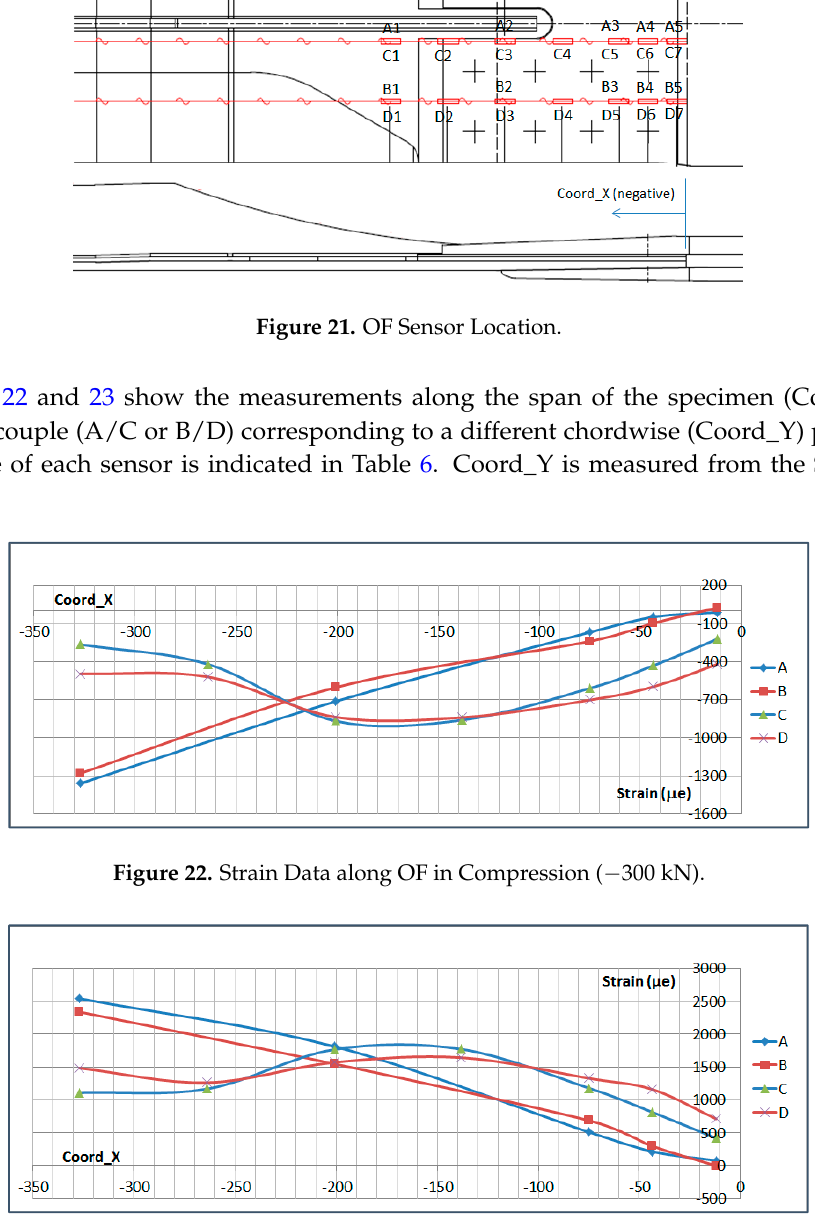
Figure 23. Strain Data along OF in Tension (650 kN).